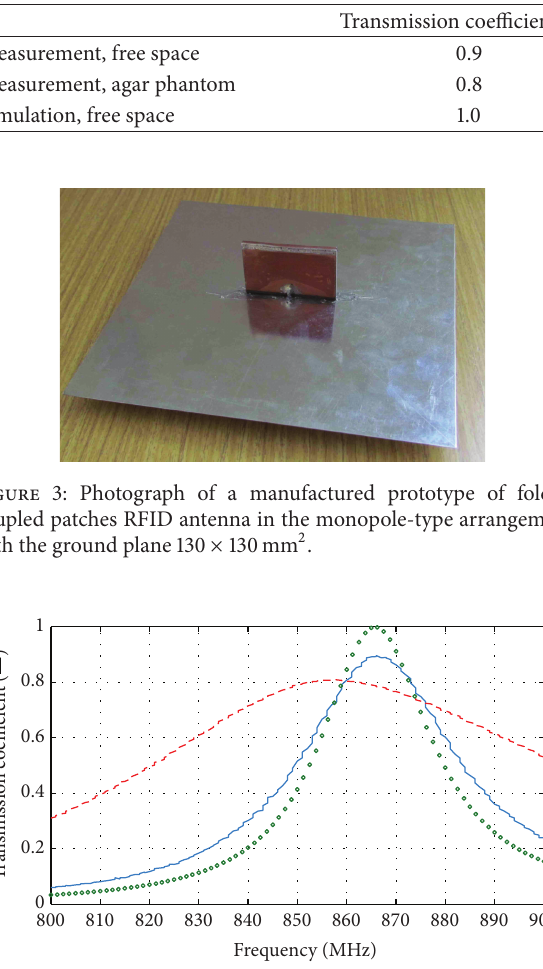
Table 1: Impedance and radiation properties of the vertically folded coupled patches RFID antenna at frequency 866 MHz.